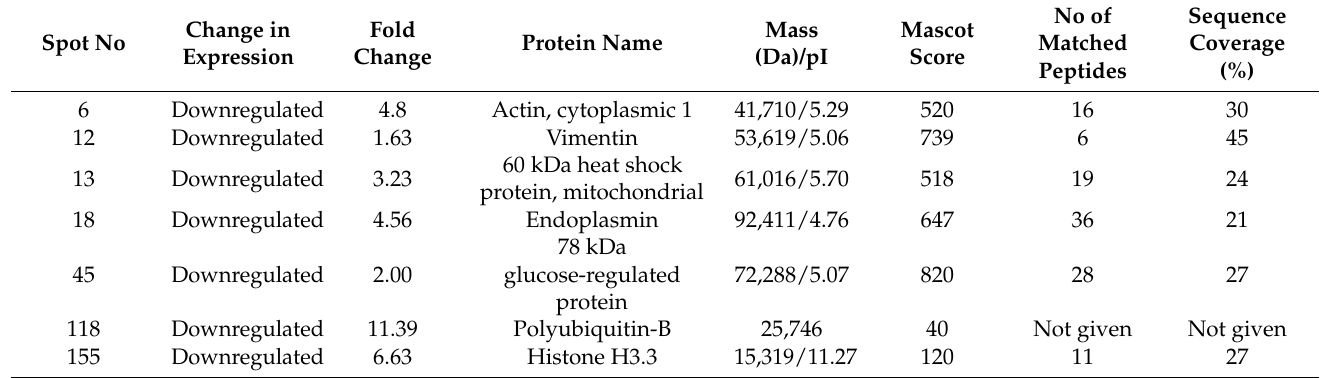
Table 2. Protein spots that underwent significant changes in expression after treatment with NH3 alone in A2780 cell line and their identification (name, mass, Da/pI, mascot score, matched peptides, percentage of sequence coverage).